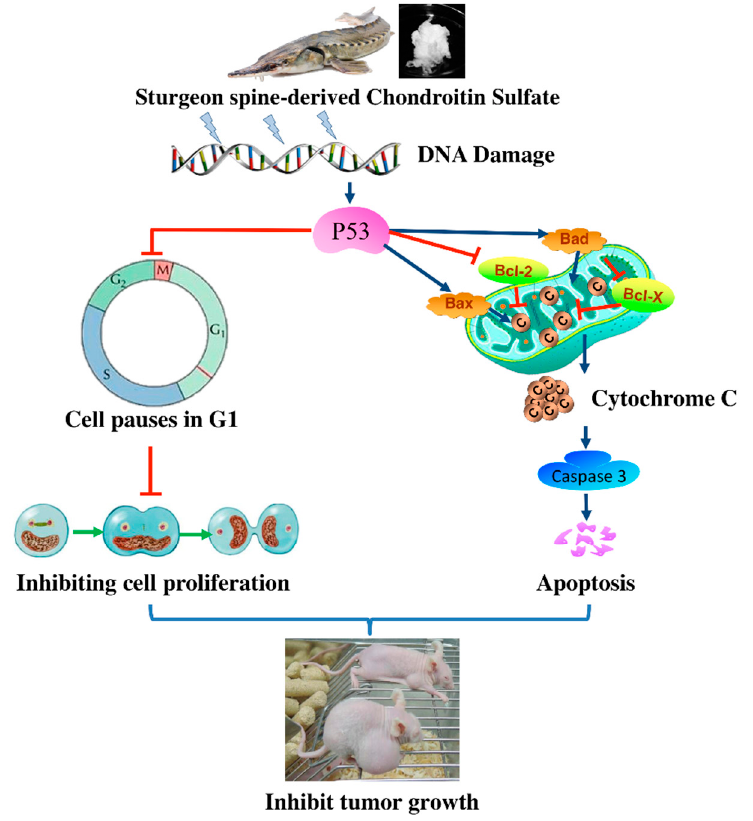
Figure 9. The potential mechanism of SCS-induced inhibition of colorectal cancer progression.